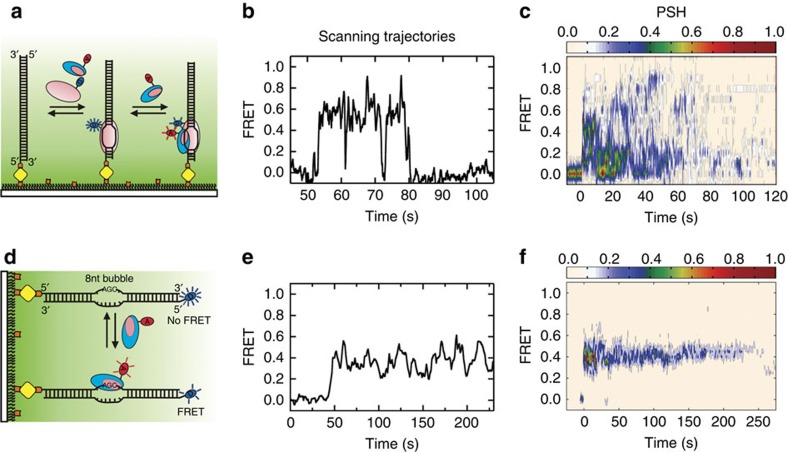
AID co-localizes with RNAP in transcription initiation bubbles and scans static ssDNA bubbles.(a) Cy3-RNAP and Cy5-AID incubated with surface-immobilized unlabelled dsDNA show co-localization of both enzymes within the transcription initiation bubble. (b) The resulting FRET trajectories exhibit fluctuations indicating AID dynamically co-localizes with RNAP, moving on the DNA relative to the polymerase (N=16). (c) Post-synchronization histogram (PSH) showing AID co-localizes with RNAP at the initiation bubble. PSHs are time-binned trajectories synchronized at the initial binding event. Intensity bar represents the frequency scale of particular FRET states (beige=low, red=high). (d) Single-molecule FRET setup for detection of AID scanning in a static transcription bubble. A Cy3-labelled dsDNA with an 8 nt bubble in the middle was immobilized on the surface, and Cy5-labelled AID was used to bind/scan in the bubble. (e) A representative smFRET trajectory (N=18). (f) PSH showing restricted AID scanning within the bubble. The time resolution here is 100 ms.